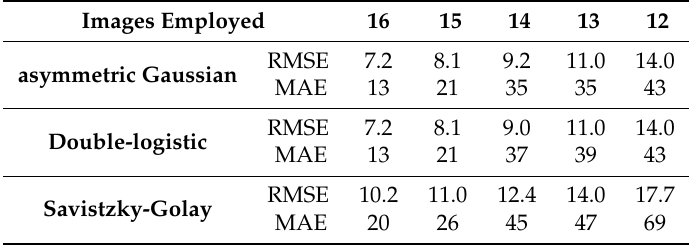
Figure 7. Estimation of EoS using ( a ) asymmetric Gaussian functions; ( b ) double-logistic functions; ( c ) adaptive Savitzky–Golay filtering; and ( d ) methodology based on particle filter. Determination factor ( R 2 ) and RMSE are provided for each method. The number of cases is n = 42. Table 3. RMSE and MAE obtained for the EoS estimation using TIMESAT.